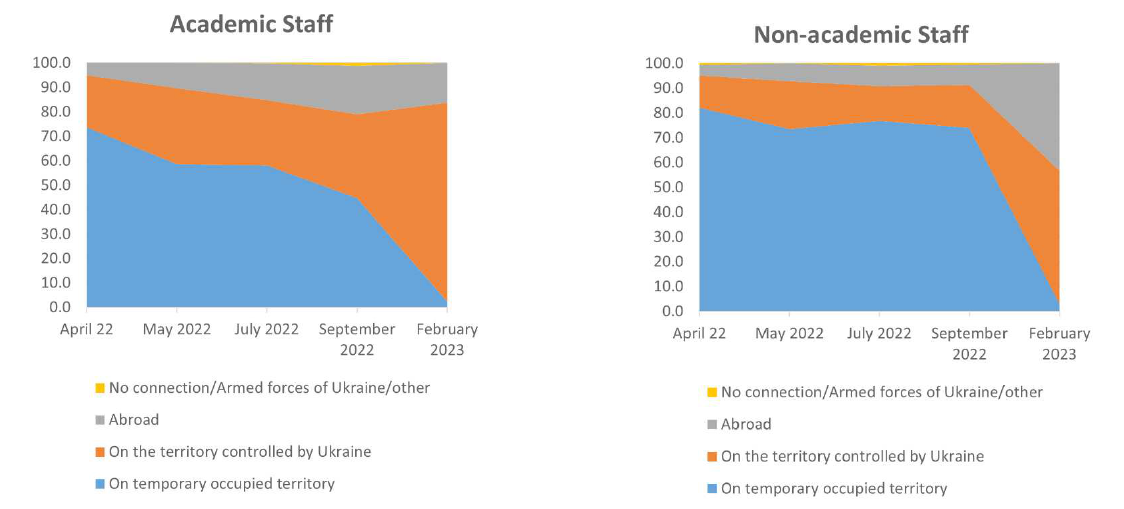
Figure 2. Relocation dynamics of the Kherson State University academic and non-academic staff (%),